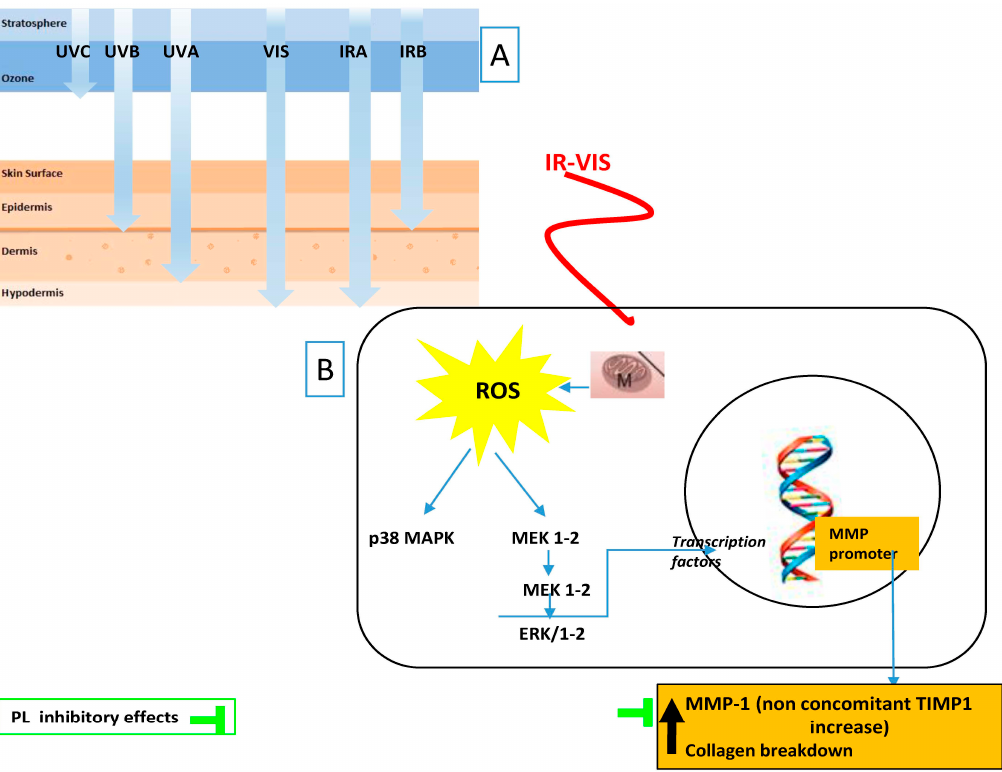
Figure 2. Tested anti IR–VIS effects of Polypodium leucotomos (PL) extract: ( A ) ultraviolet radiation (UV), visible light (VIS), and infrared radiation (IR) depth penetration in the skin; and ( B ) main PL effects reflect its capacity to decrease MMP-1 upregulation induced by cutaneous exposure to IR–VIS. Black arrows indicate increased/decreased effects due to IR–VIS.